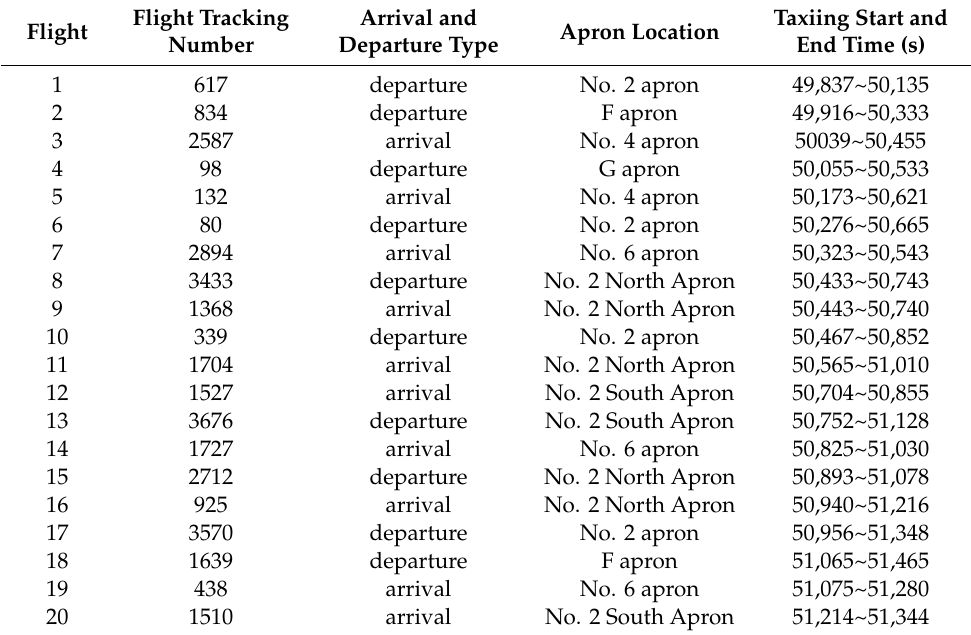
Table 3. Airport Flight Schedules.